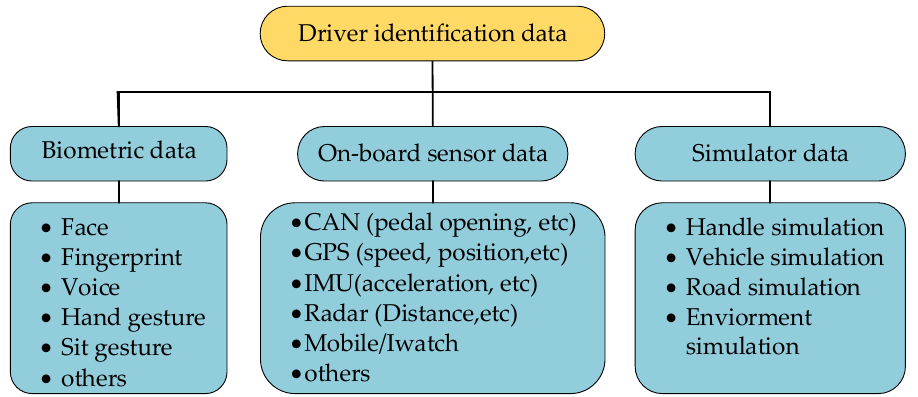
Figure 2. Driver identification data classification.